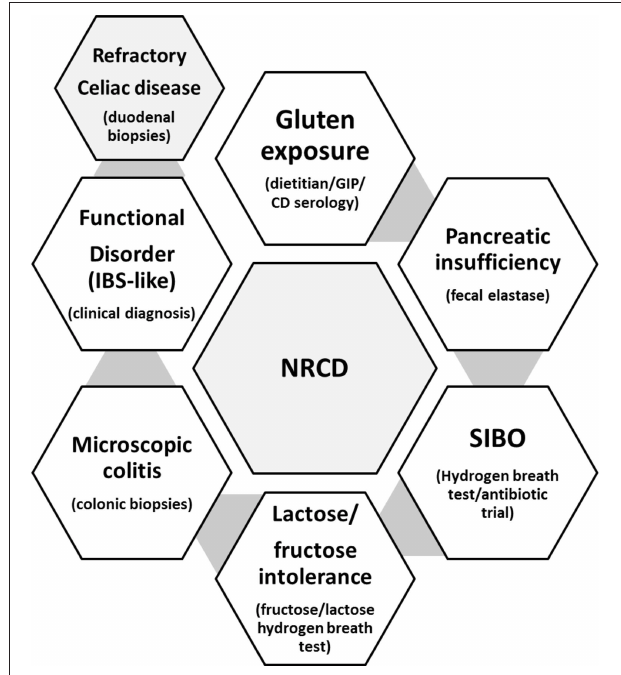
FIGURE 1 | Common causes for persistent symptoms in the follow-up of patients with CeD (non-responsive celiac disease; NRCD), and common tests used in clinical practice for the diagnosis of each concomitant